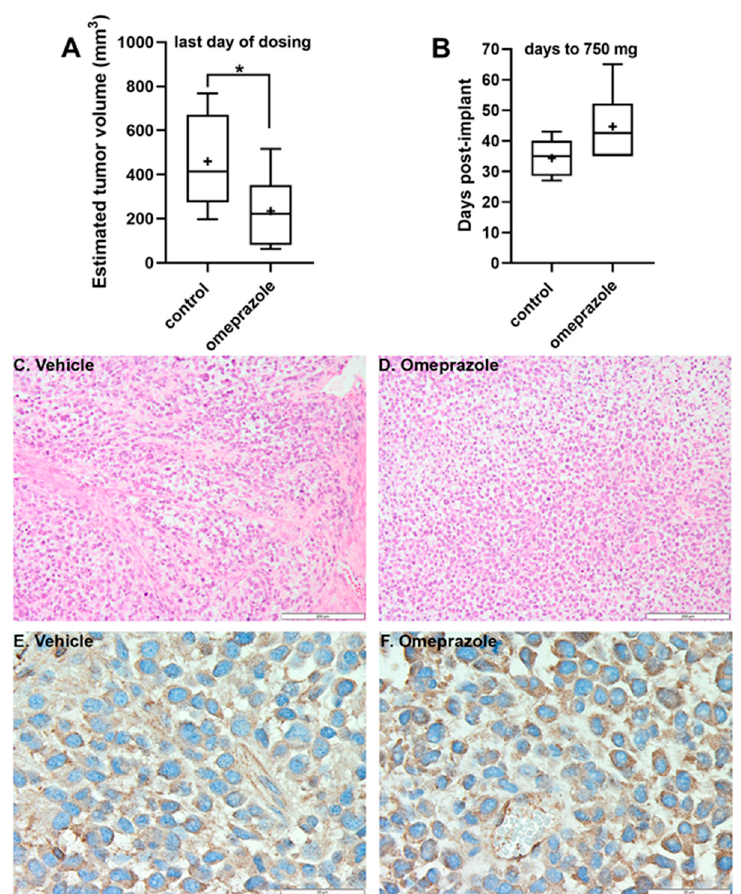
Figure 6. In vivo inhibitory effects of OME. OME inhibited ( A ) and delayed ( B ) tumor growth in the 15-037 GBM PDX tumor model. Tumors from control ( n = 5) and OME treated ( n = 6) mice were measured daily. In the box and whisker plots, the horizontal line represents the median, with the mean indicated by the +. The whiskers represent the minimum and maximum. * p < 0.05 by one-tailed t-test. H&E staining ( C , D ) of representative tumor tissues from control ( C ) and OME mice ( D ) revealed a similar tumor cell density. Scale bars are 200 µM. IHC to visualize AhR ( E , F ) demonstrated equivalent cytoplasmic staining in both the control ( E ) and OME mice ( F ). Scale bars are 50 µM.